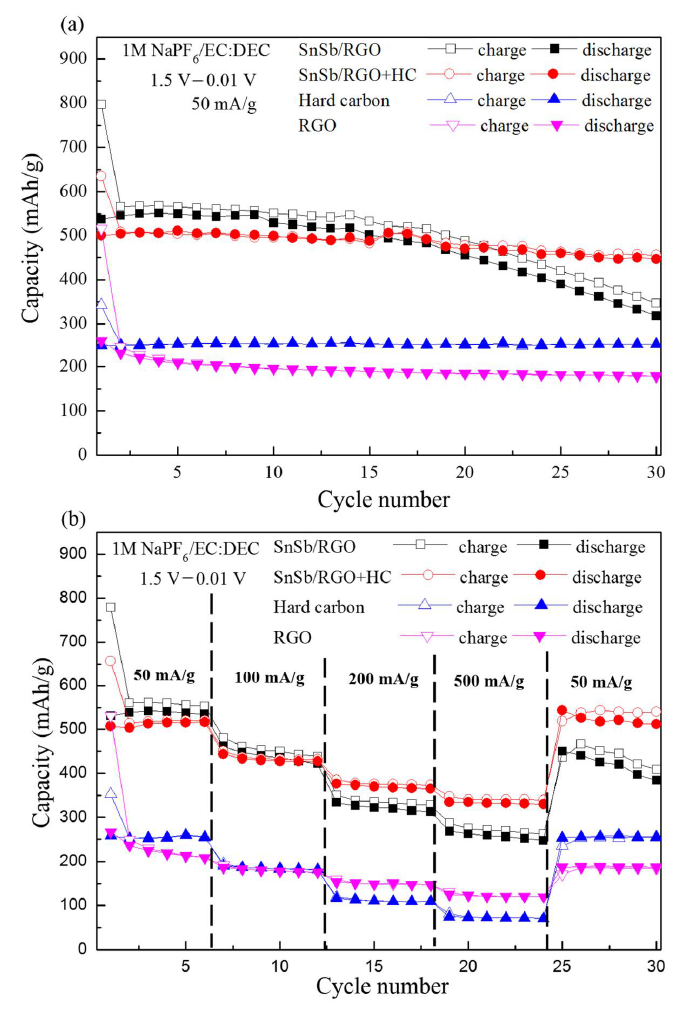
Figure 3. ( a ) Cyclability of SnSb/RGO, SnSb/RGO+C, hard carbon, and RGO. ( b ) Rate capabilities of SnSb/RGO, SnSb/RGO+C, hard carbon, and RGO.